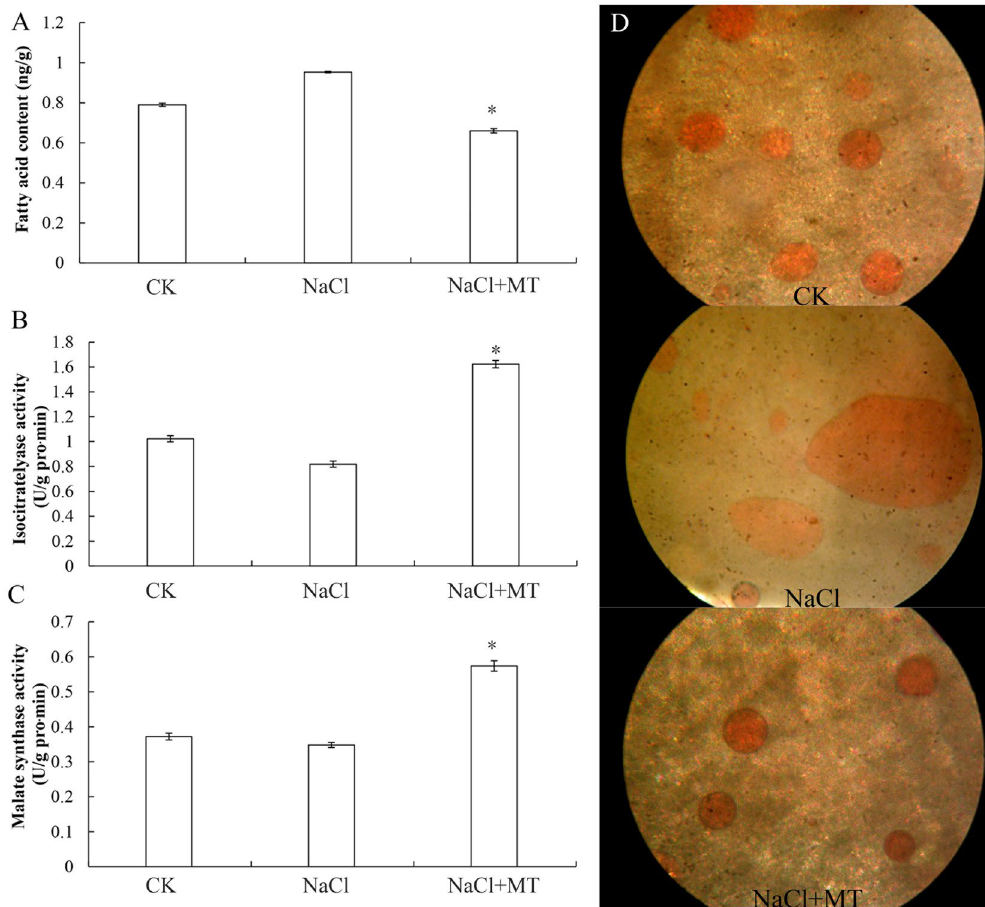
Figure 6. Effects of 1 μ M melatonin on lipid content ( A , D ) and activities of isocitrarelyase ( B ) and malate synthase ( C ) during germination of cucumber seeds under salt stress. Lipid droplets in ( D ) were studied using 0.5% sudan red staining. Vertical bars represent ± S.E (n = 3).